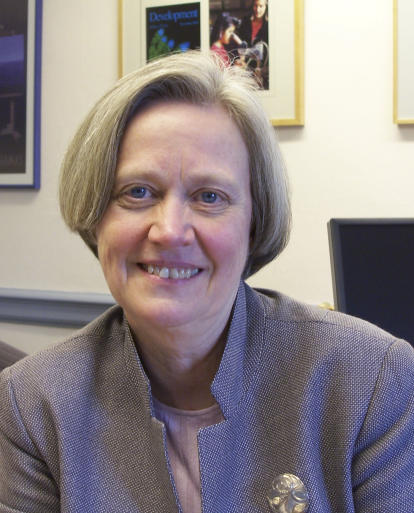
Shirley Tilghman